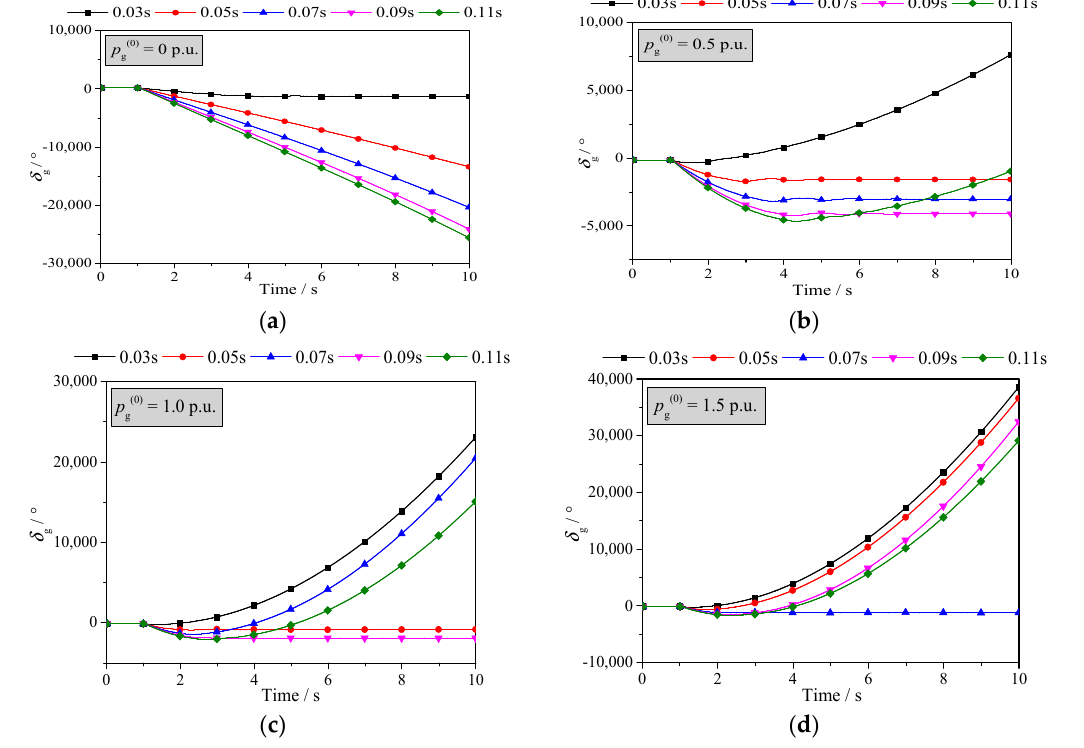
Figure 12. The swing curves of the sending-end generator power angle (detailed model). ( a ) p g(0) = 0 p.u.; ( b ) p g(0) = 0.5 p.u.; ( c ) p g(0) = 1.0 p.u.; ( d ) p g(0) = 1.5 p.u.